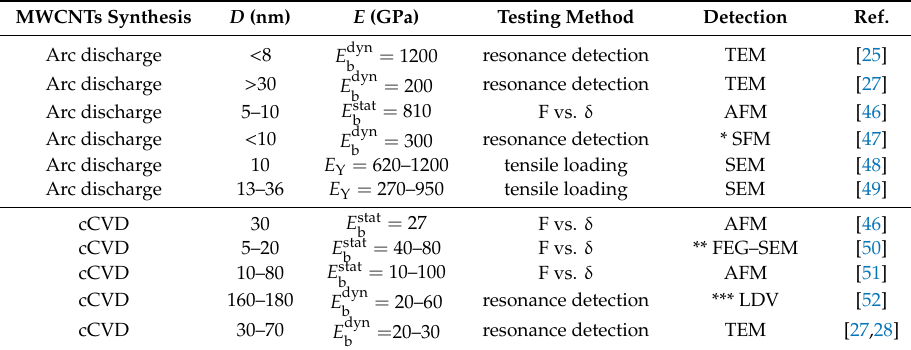
Table 1. Previous studies of the bending modulus of MWCNTs with di ff erent diameters, produced by the most common synthesis methods as reported by other authors. The Young’s ( E Y ) and the ) bending modulus values are approximated to the values given in the static ( E stat ) and dynamic ( E dyn b b literature. “F vs. δ “ stands for force-versus-deflection testing, see